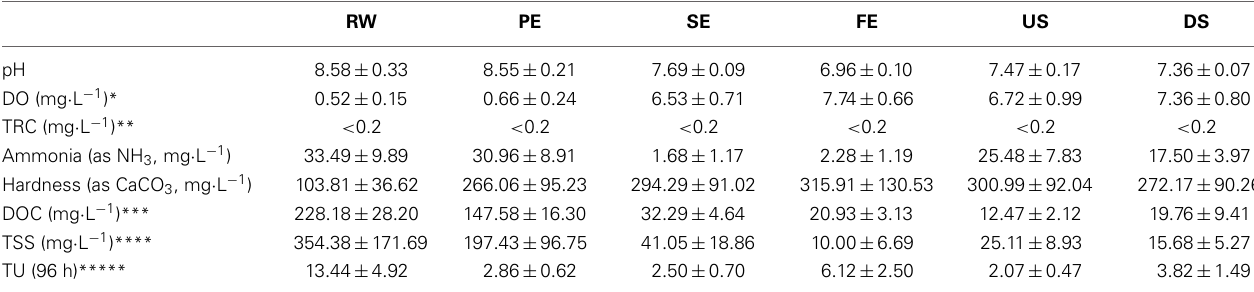
Table 1 | Mean and standard deviation of toxicity and chemical characteristics of WTP effluents and the adjacent stream water.